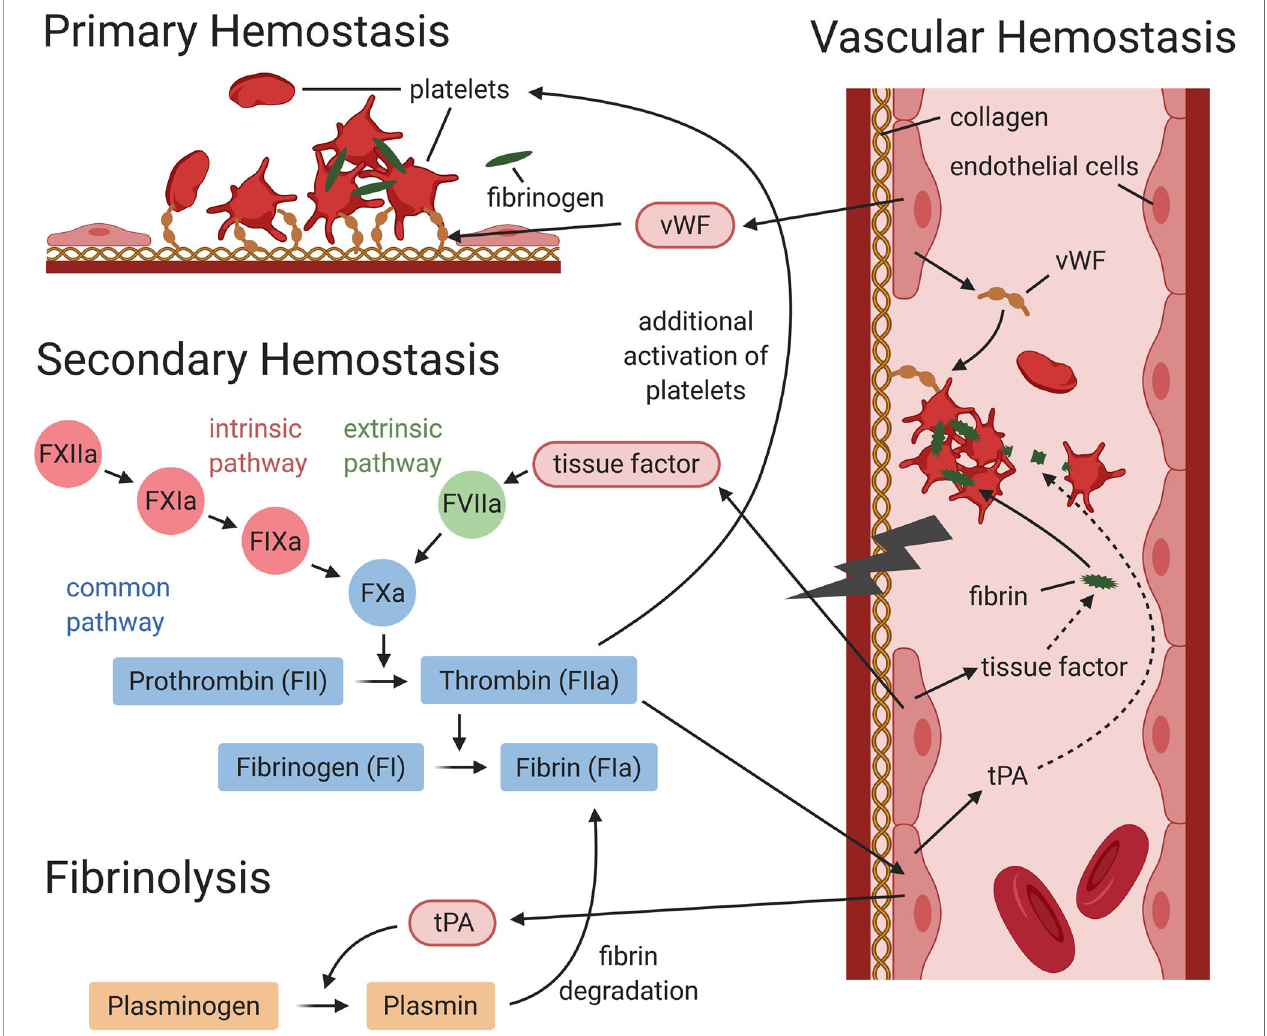
FIGURE 2 | Interaction between vascular, primary and secondary hemostasis, and fi brinolysis (simpli fi ed graphic). During primary hemostasis platelets adhere at the vessel injury site, either directly or via von Willebrand factor (vWF), to subendothelial collagen. Activated platelets aggregate and fi brinogen forms bridges between activated platelets to form a platelet plug. During secondary hemostasis, the coagulation cascade is activated via the intrinsic and/or extrinsic pathway. Both lead to the activation of the common pathway, which will result in the generation of thrombin and fi brin. During fi brinolysis, plasmin induces degradation of fi brin. Vascular endothelial cells express and release factors, which contribute to primary and secondary hemostasis and fi brinolysis. Endothelial cells release von Willebrand factor (needed for platelet adhesion), tissue factor (triggers the activation of the extrinsic pathway), and tissue plasminogen activator (tPA), which mediates plasmin generation. This fi gure was designed using